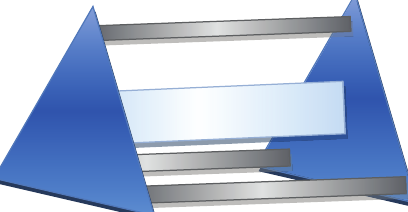
Table 2: EAP electrical parameters.